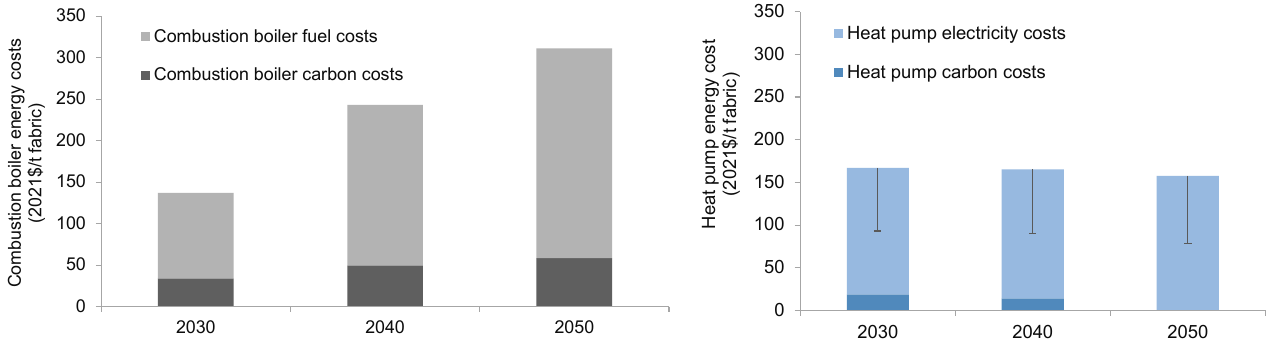
Figure 13. Energy costs per unit of production for the textile wet-processing industry in China.